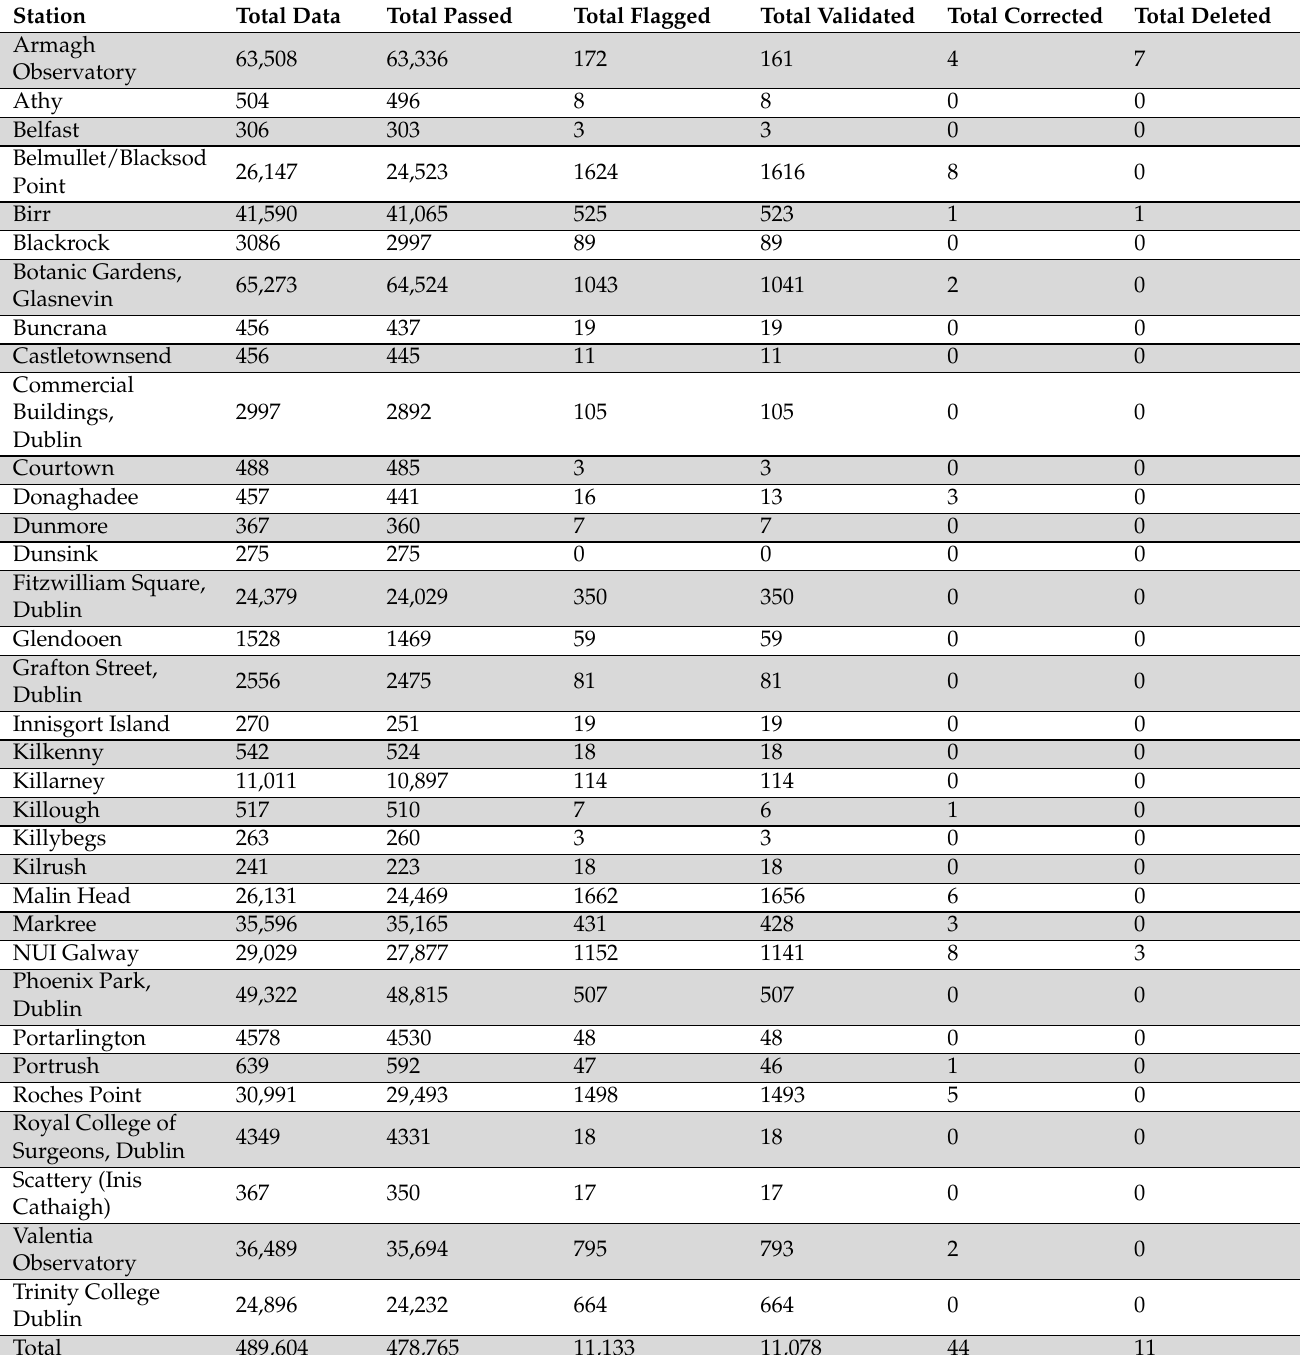
Table A8. Total of MIN data that failed the quality control test flag 9 and total validated, corrected and deleted